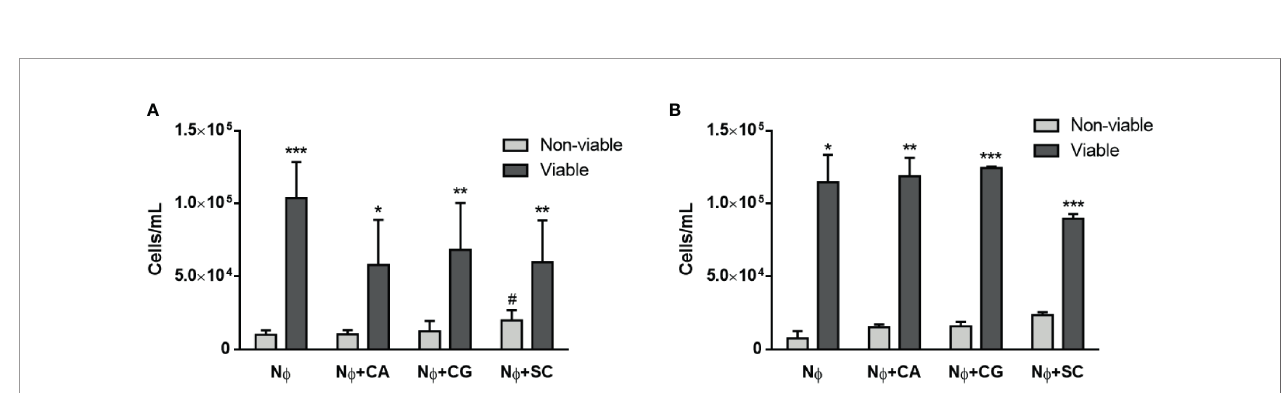
FIGURE 4 | Neutrophils ’ viability upon yeasts interaction. Trypan blue assays were performed to distinguish between viable and non-viable neutrophils (N ɸ ) at 1 h (A) and 3 h (B) post infection with C. albicans (CA), C. glabrata (CG) and S . cerevisiae (SC). Data represent at least three independent experiments (means ± SEM). *p<0.05, **p<0.01, ***p<0.001, in viable vs. non-viable conditions; # p<0.05, vs. non-viable N ɸ .